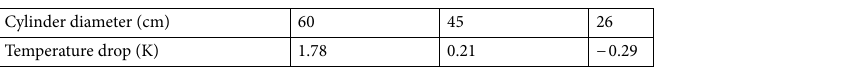
Cylinder diameter (cm)